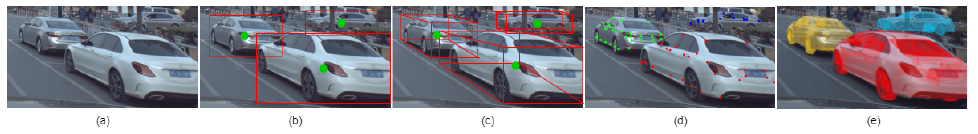
Figure 1. Vehicle object detection: ( a ) raw image; and ( b – e ) vehicle objects labeled by 2D, 3D bounding boxes, keypoints, and 3D